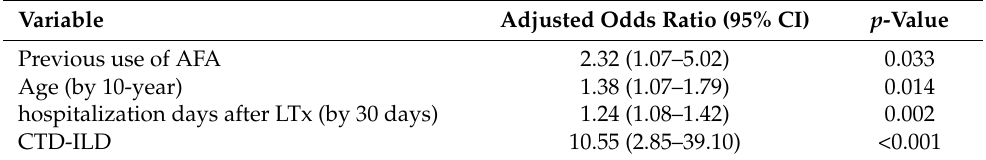
Table 3. Multivariate analysis of patients who developed fungal infections after lung